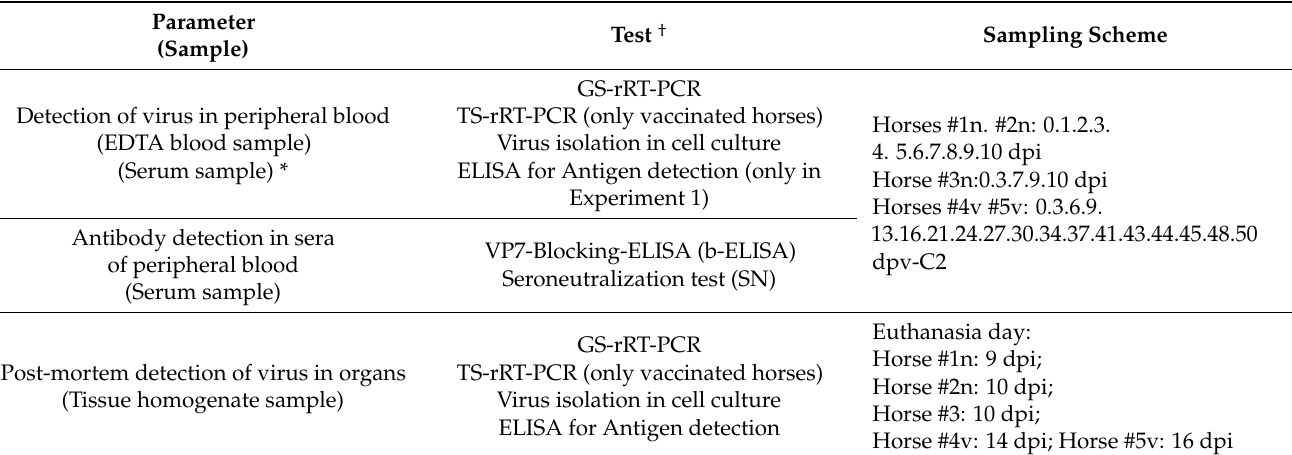
Table 1. Parameters investigated, tests, and sampling scheme in Experiments 1 and